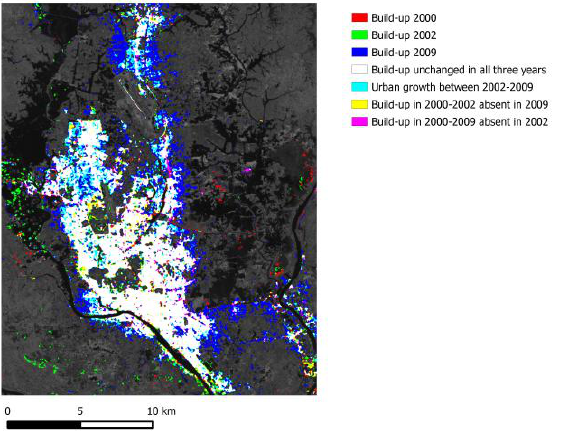
Figure 12. Urban growth map (2000-2002-2009) 4.2 Flood-prone areas